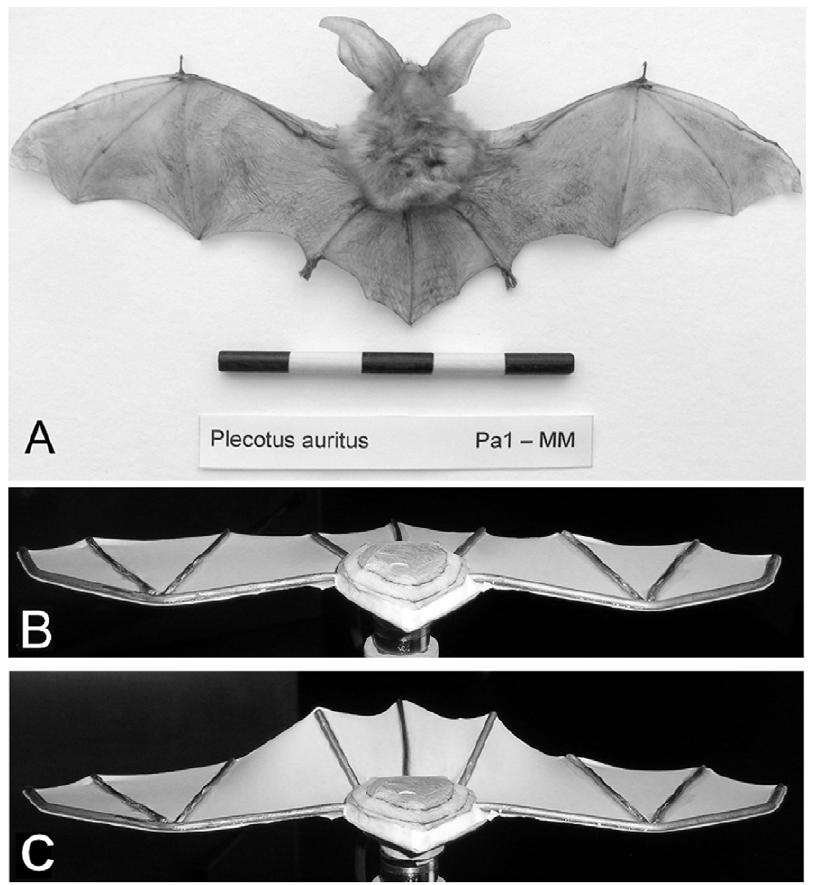
Figure 1. Plecotusauritus specimen and the completed wind-tunnel model. A: Dried P. auritus bat specimen upon which the bat model was based (Scale bar = 100 mm). B and C: Completed bat model at the extremes of the leg positions (B: Leg angle ( b )=0 u , C: Leg angle ( b )=60 u ), showing the effect on the tail membrane angle of attack and the increased wing camber (termed leg-induced wing camber). Leg angle adjustments were made via small screw mountings hidden within the body of the model. The model was mounted upside down in the wind-tunnel to minimise the aerodynamic effect of the wake from the support, since the tail is then deflected away from the support, instead of towards. Note that the large ears of P. auritus were excluded from the model, since this investigation was primarily concerned with the aerodynamics of the tail membrane.